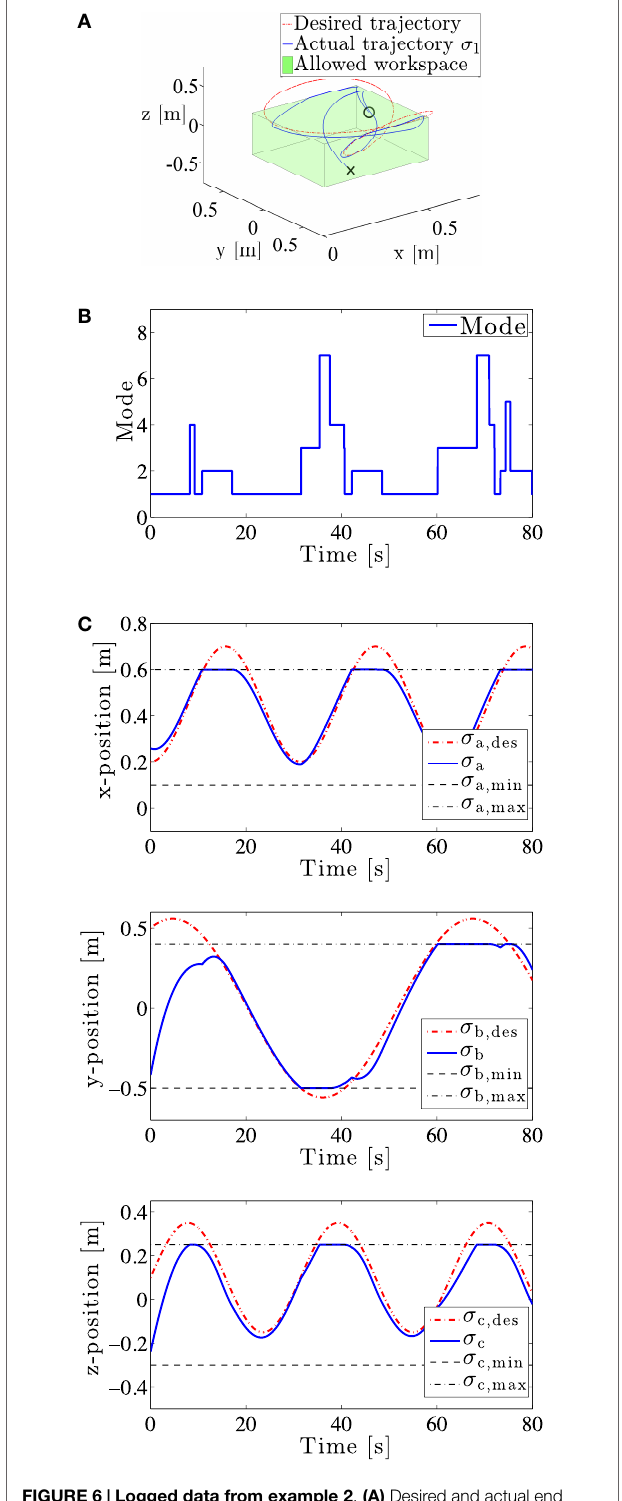
FIGURE 6 | Logged data from example 2 . (A) Desired and actual end trajectory plotted in red and blue, respectively. The allowed workspace is illustrated by the green box. Initial and end position marked by x and o , respectively. (B) Active mode over time. (C) Reference and actual end effector position in x , y , and z -direction with valid workspace